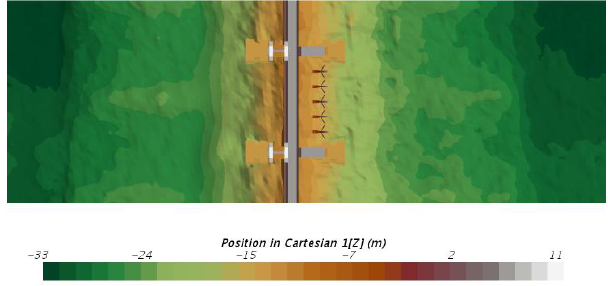
Fig. 4. Contour plot of the bed elevation. Dimension are with reference to